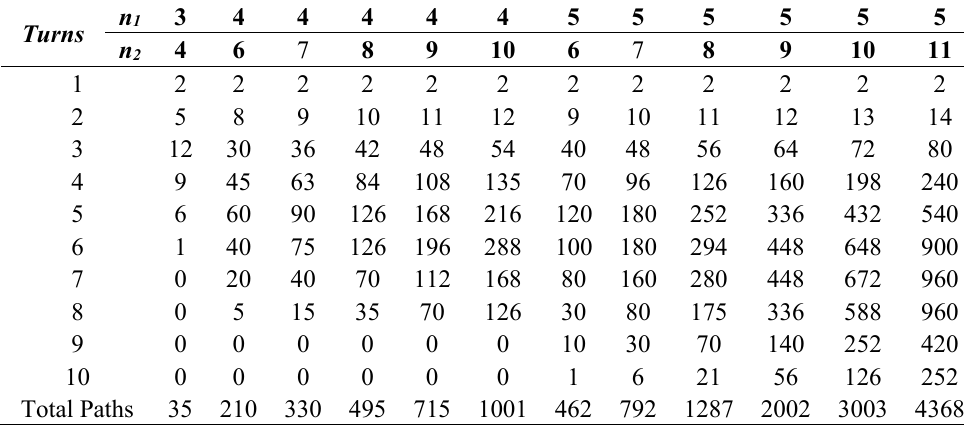
Table 1. The path distributions with respect to their number of turns.